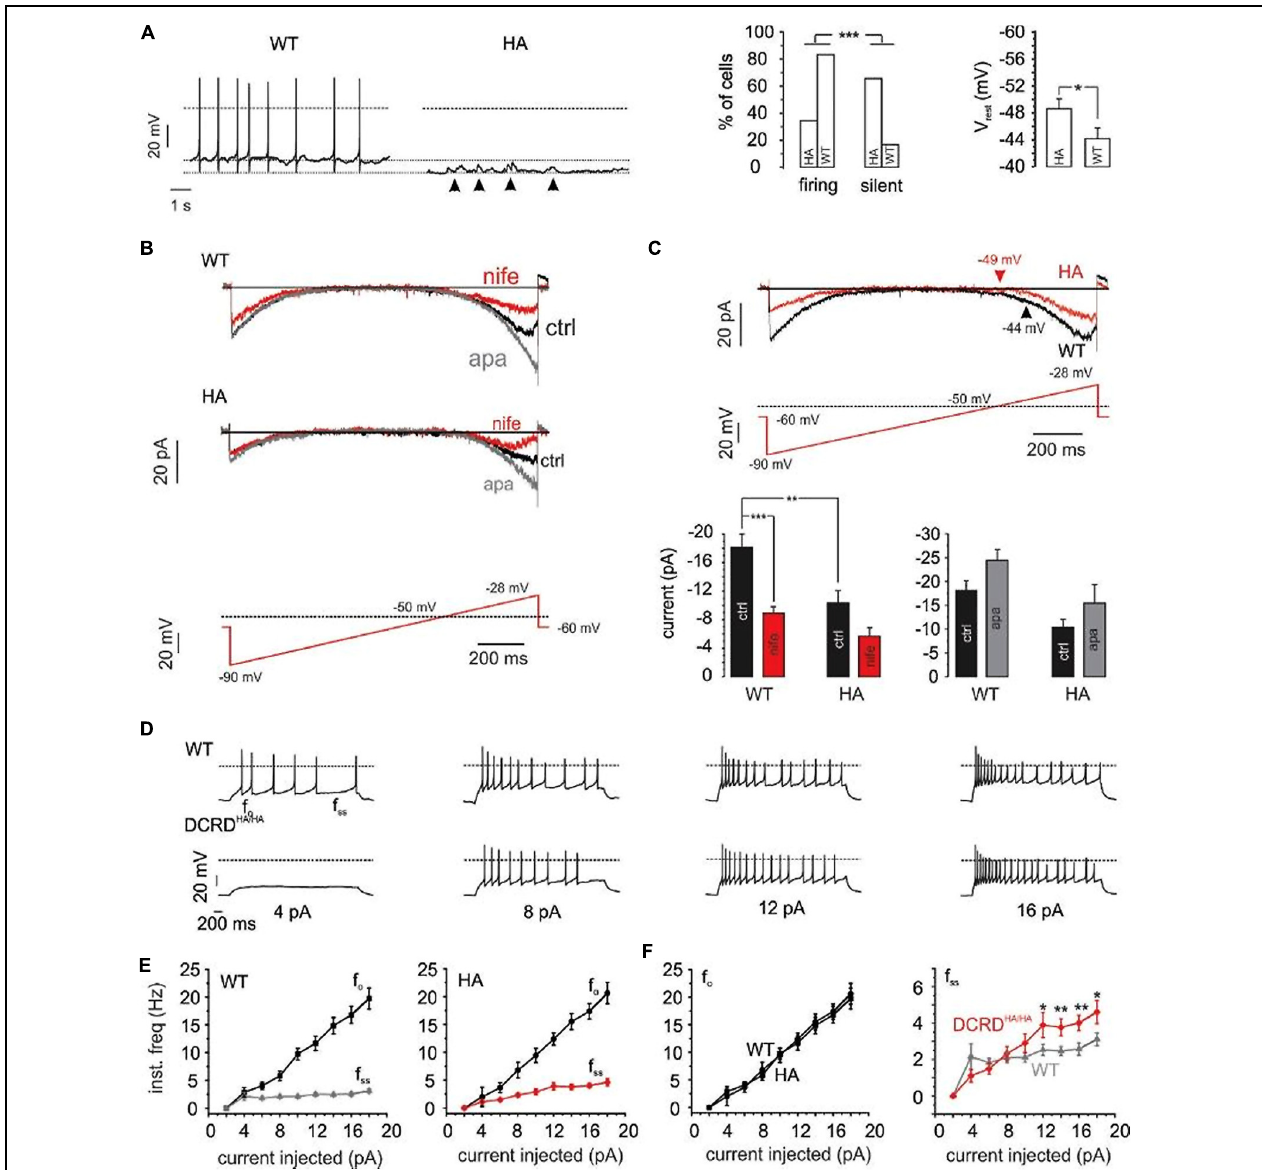
FIGURE 10 | Firing properties of WT – vs. DCRD HA / HA MCCs. (A) Left: current-clamp traces of representative WT (black) and Cav1.3DCRD HA / HA (red) MCCs without current injection. Dashed lines indicate baseline, dotted line indicates 0 mV. Right: percent of firing vs. silent cells and comparison of V rest for WT ( n = 18) and Cav1.3DCRD HA / HA (HA, n = 32) MCCs. Significance testing on categorical data was performed by RxC contingency tables and a chi–square test ( ∗∗∗ p < 0.001) while a Student’s t -test was used for V rest ( ∗ p < 0.05). (B) Averaged Na + , K + , and Ca 2 + -currents of WT ( n = 9) and Cav1.3DCRD HA / HA ( n = 7) MCCs to the illustrated slow ramp protocol in the absence (black, ctrl) or presence of nifedipine (3 μ M, red) and during SK channel block by apamin (200 nM, gray). (C) Top: overlay of WT (black) and Cav1.3DCRD HA / HA averaged currents (red) elicited by the indicated ramp